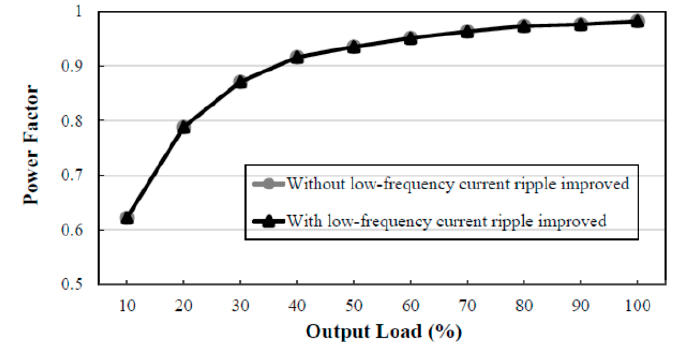
Figure 14. Curve of power factor versus output load under 220 V input voltage.